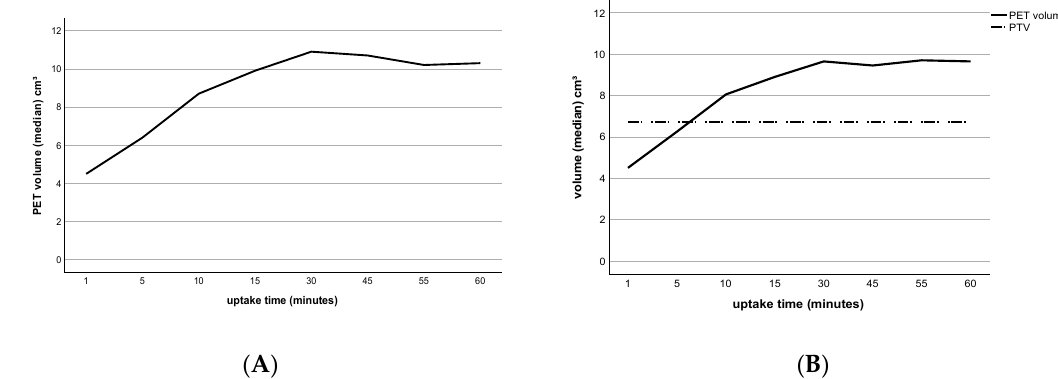
Figure 5. Ga-68-DOTATOC-PET volumes and corresponding planning target volume (PTV, as obtained from medical records). ( A ) Line diagram of median PET volume of all meningioma lesions as a function of uptake time; ( B ) line diagram of median PET volume as a function of uptake time (solid line) and the median PTV for comparison (dashed line). Median PET volume differs from (B) because only 12/15 patients were included due to missing PTV.